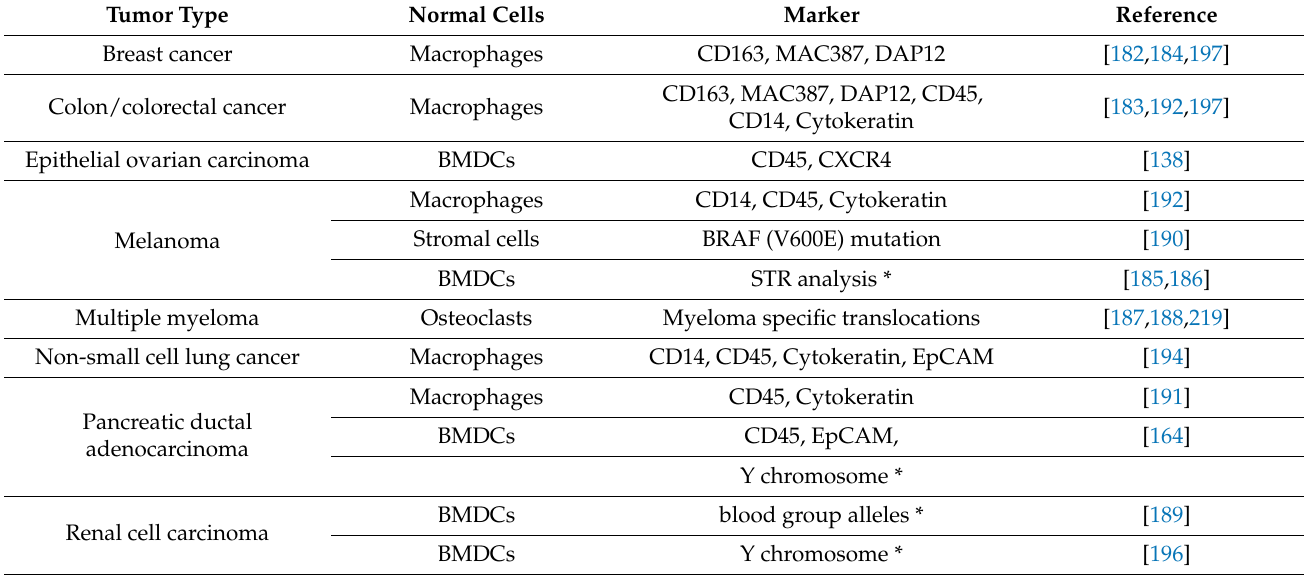
Table 1. Identification of tumor hybrid cells in human